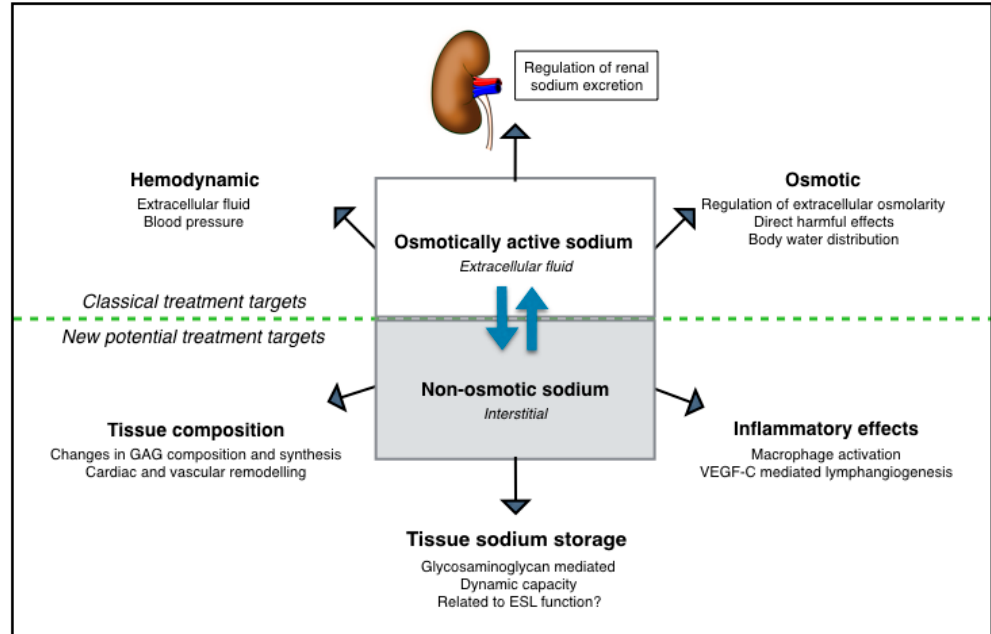
Figure 2. Different mechanisms of sodium handling and their effects on the human body with regard to possible treatment targets (either life-style or pharmacologically mediated). Below the dotted line the mechanisms associated with non-osmotic sodium storage are visualized, for these mechanisms further research into potential treatment targets is necessary.